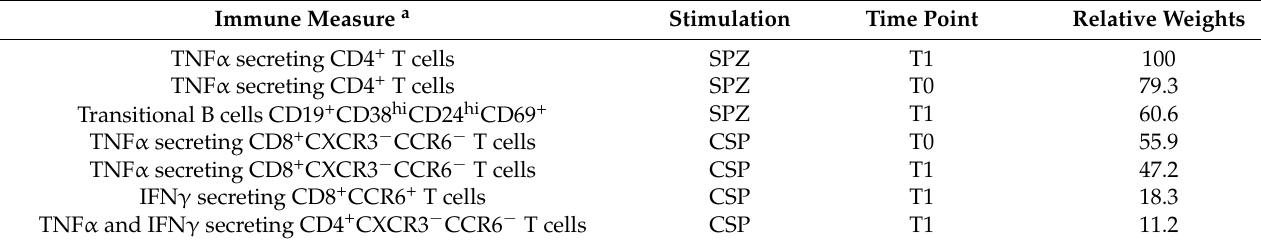
Table 2. Immune measures predictive of protection